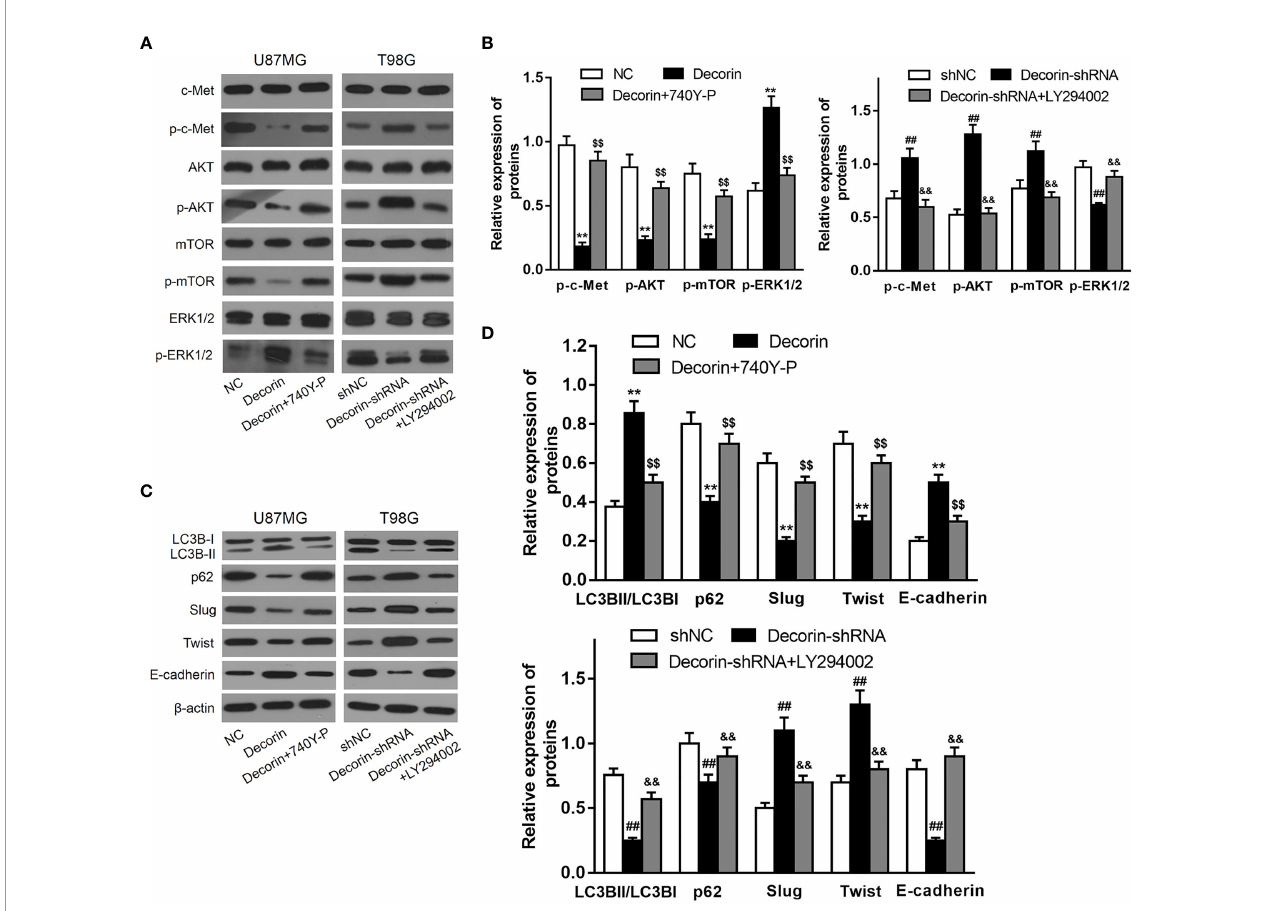
FIGURE 5 | Decorin suppresses EMT via c-MET/Akt/mTOR signaling pathway in glioma cells. (A) U87MG and T98G cells were infected with decorin-overexpressing lentivirus and decorin-shRNA lentivirus, respectively. U87MG were treated with 740Y-P, a PI3K activator, and T98G cells with the inhibitor LY294002. The cells were then harvested and lysed for the detection of p-c-Met, c-Met, p-Akt, Akt, p-mTOR, mTOR, p-ERK1/2 and ERK1/2 by western blot. The phosphorylated levels of c-Met, Akt and mTOR were notably down-regulated and the level of p-ERK1/2 was increased in decorin-overexpressed U87MG cell lines compared with the U87MG-NC cells. In contrast, the phosphorylated levels of c-Met, Akt and mTOR were signi fi cantly up-regulated, whereas the level of p-ERK1/2 was decreased in T98G-decorin- shRNA cells. The U87MG-decorin cells, the expression levels of p-c-Met, p-Akt and p-mTOR were signi fi cantly increased, and p-ERK1/2 level was decreased after treatment with 740Y-P, but these expression changes were reversed in the T98G-decorin-shRNA cells after treatment with LY294002. (B) Measurement data of (A) (means ± S.D. @ of 3 independent experiments). **P < 0.01 vs. NC; $$ P<0.01 vs . Decorin; ## P < 0.01 vs. shNC; && P < 0.01 vs. Decorin-shRNA. (C) LC3B-II/LC3B-I expression ratio and E-cadherin was decreased in the decorin-overexpressed U87MG cells after 740Y-P treatment, but the levels of P62, Slug and Twist were augmented in these cells. Contrarily, LY294002 treatment led to reduced expressions of p62, Slug and Twist, and up-regulated the expressions of p-ERK1/2, E-cadherin and LC3B-II/ LC3B-I conversion. (D) Measurement data of (C) (means ± S.D. @ of 3 independent experiments). **P < 0.01 vs. NC; $$ P < 0.01 vs. Decorin; ## P < 0.01 vs. shNC; && P < 0.01 vs.